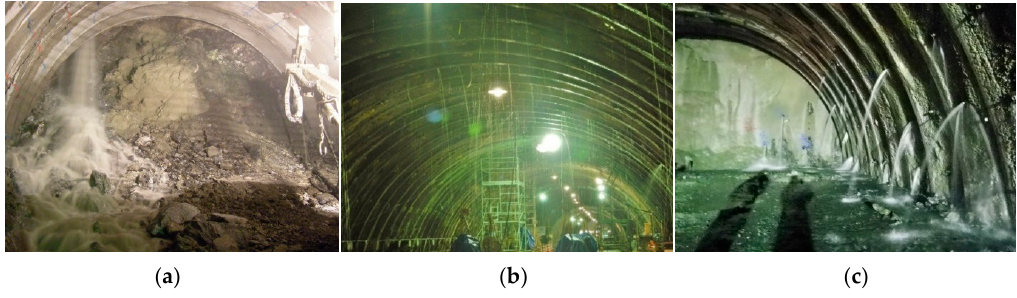
Figure 4. Leakage problems during the tunnel excavation: ( a ) Sudden water inrush during tunneling; ( b ) Groundwater inflow and water drops; ( c ) Gushing water in the tunnel.